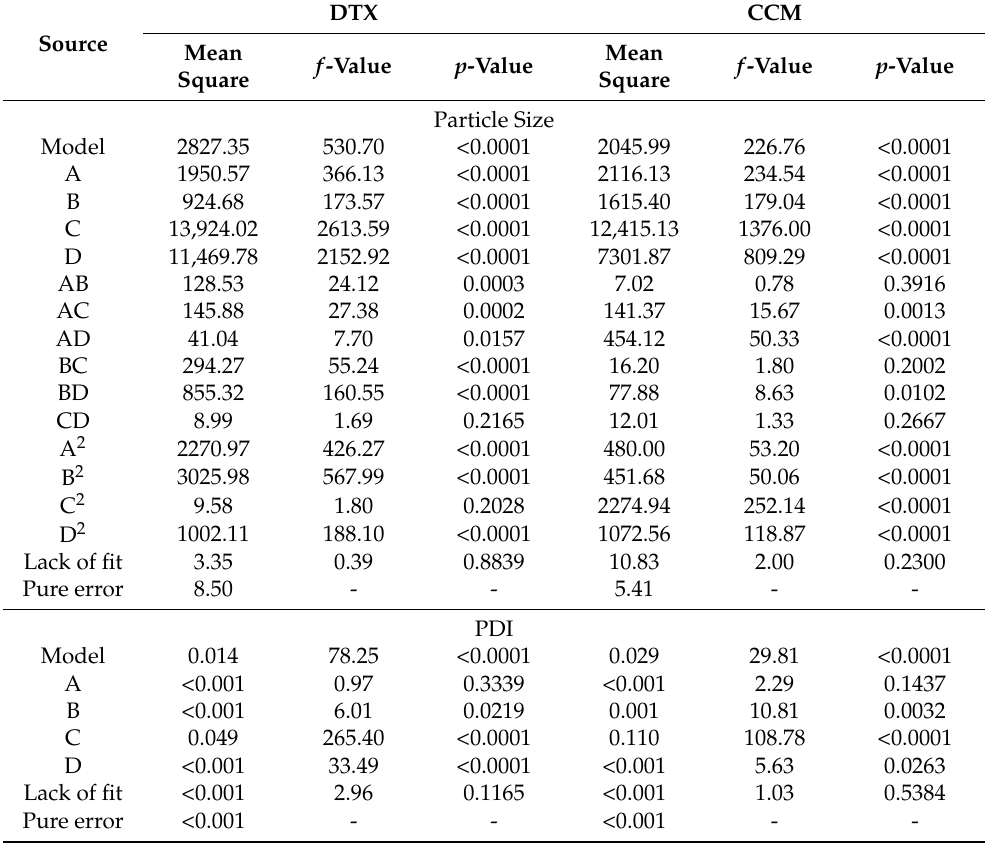
Table 2. Analysis of variance of the fitted quadratic and linear equations on particle size and